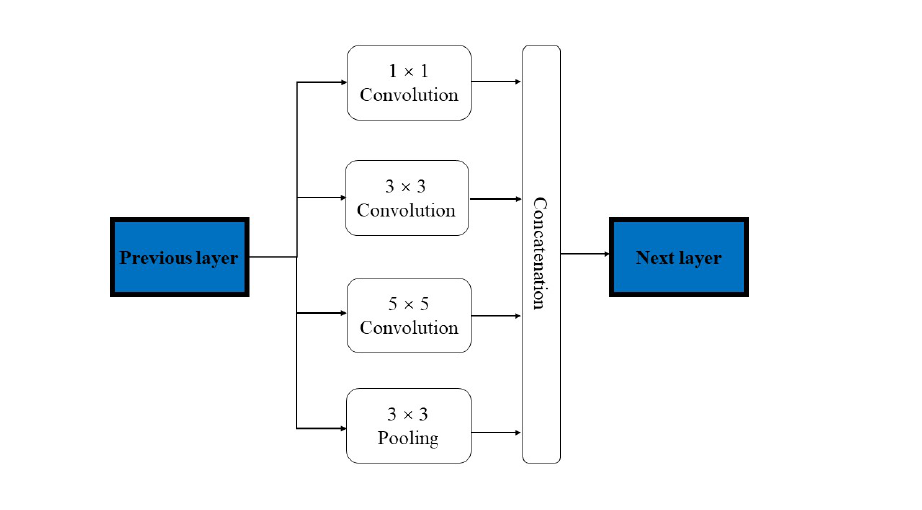
Figure 2. Structure of Inception module.